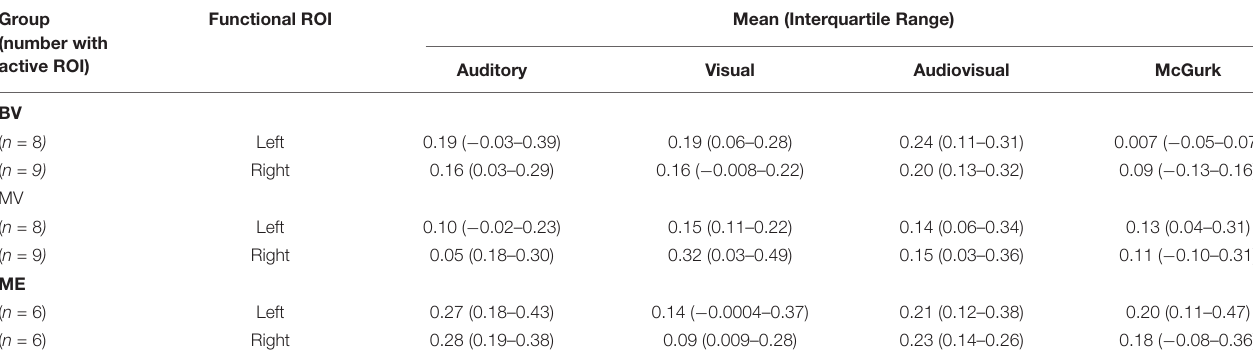
TABLE 4 | Median and interquartile range of the mean beta weight signal in each ROI for experiment 2: region of interest analysis. Group Functional ROI Mean (Interquartile (number with active ROI)